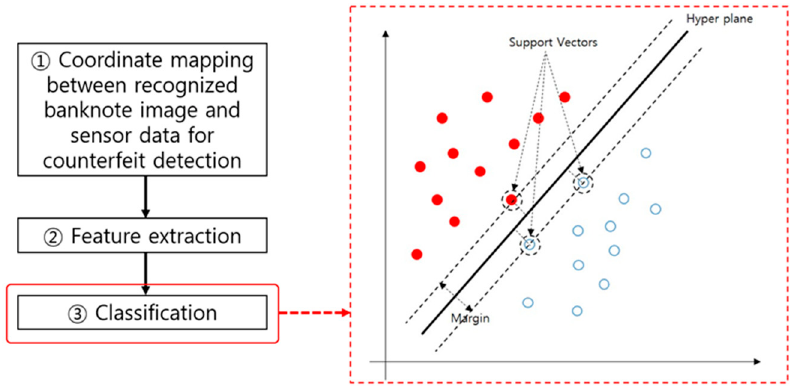
Figure 16. SVM-based counterfeit banknote classification in the counterfeit banknote detection process flow.